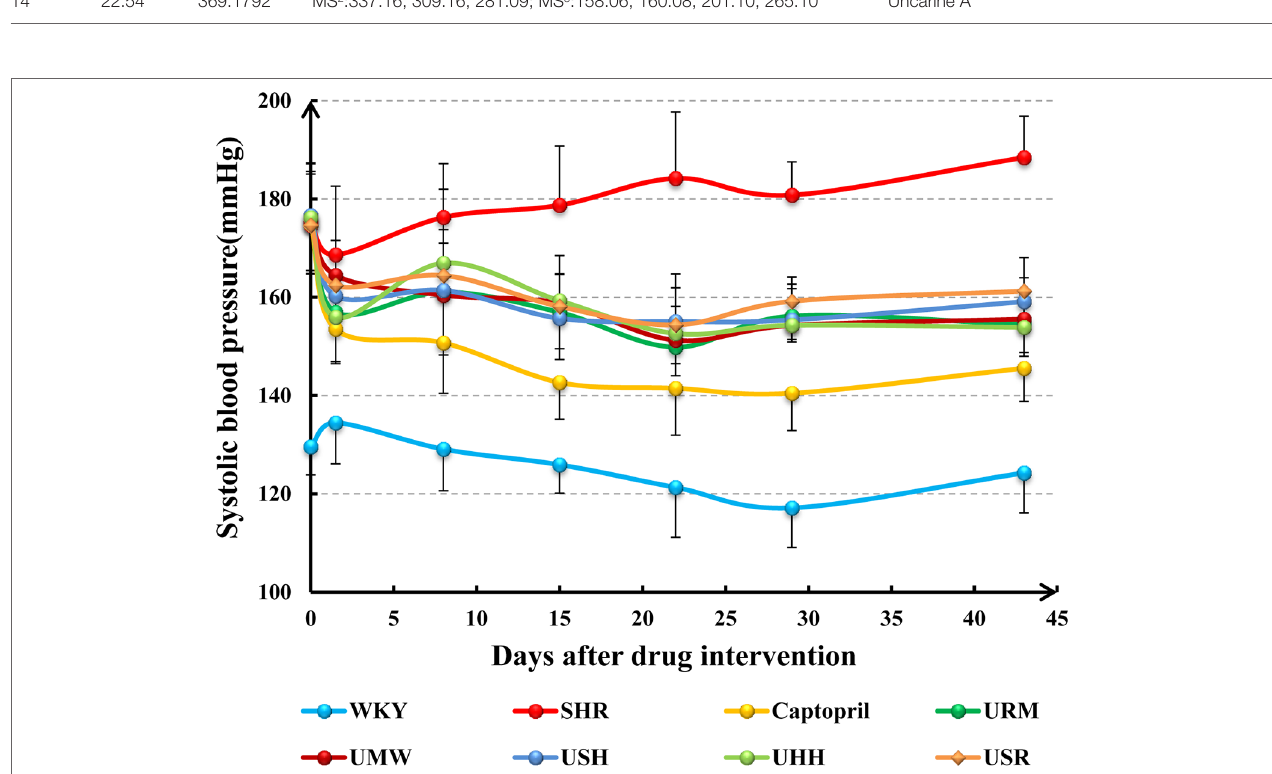
FIGURE 2 | Systolic blood pressure (SBP) measured from 0 to 43 days of treatment with captopril, URM, UMW, USH, UHH, and USR.